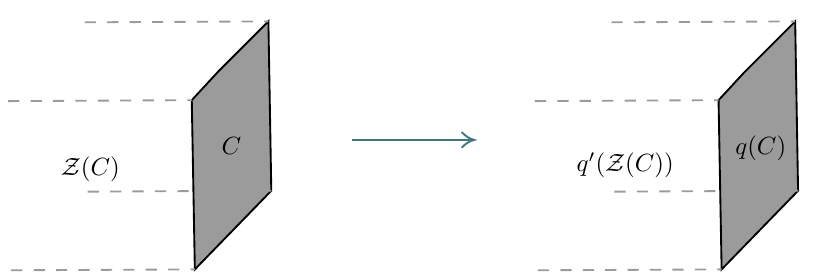
Figure 6 . Galois conjugation on the bulk induces a Galois action on the boundary and vice-versa. of K as a vector space, where n is the finite degree of the field extension. The Galois C action by some element q ∈ Gal ( K